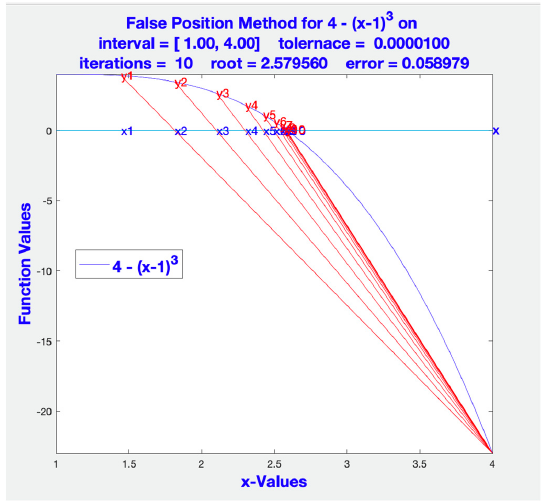
Figure 1. Convex function concave up, right endpoint fixed.